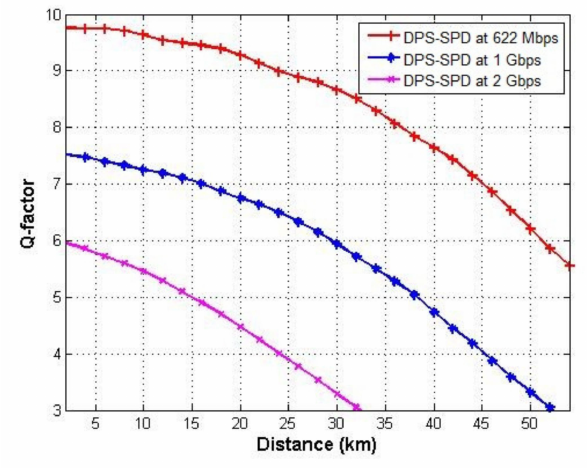
Figure 10. Q-factor versus transmission distance for DPS code using SPD detection scheme at 622 Mbps, 1 Gbps, and 2